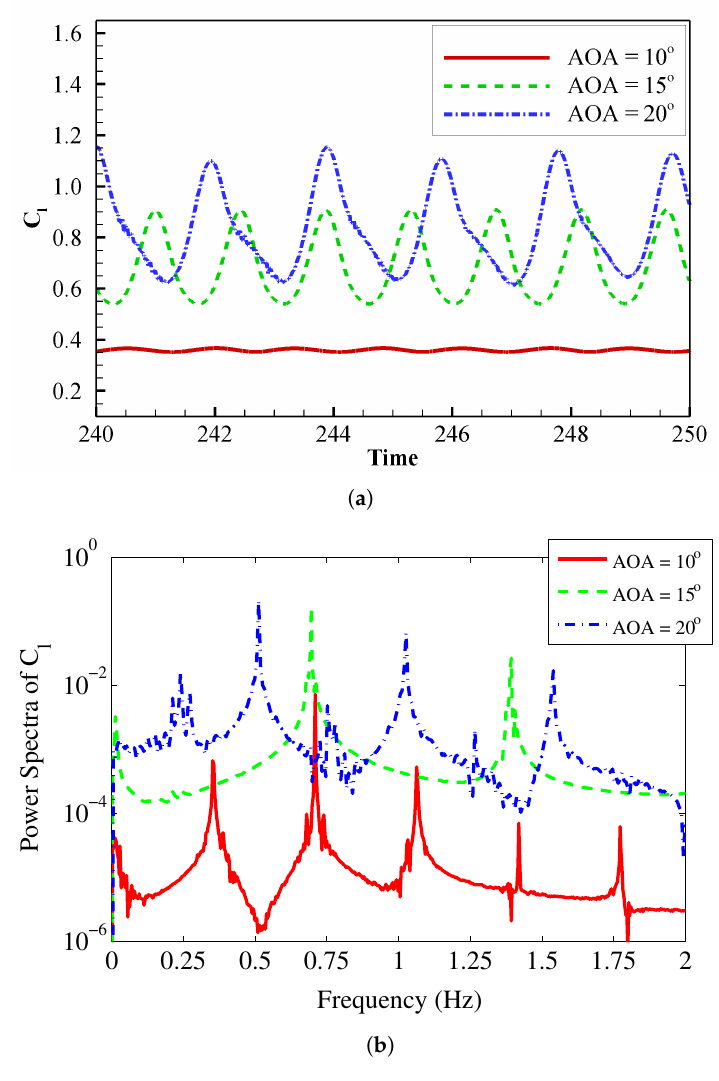
Figure 8. ( a ) Time histories of C l , ( b ) Power spectra of C l at AOA = 10 ◦ , 15 ◦ , and 20 ◦